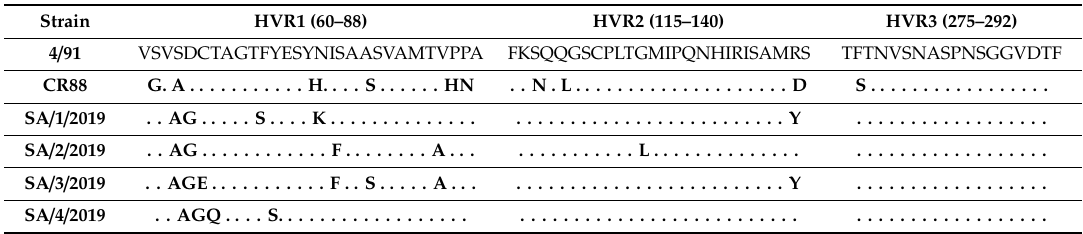
A dot indicates an identical amino acid.